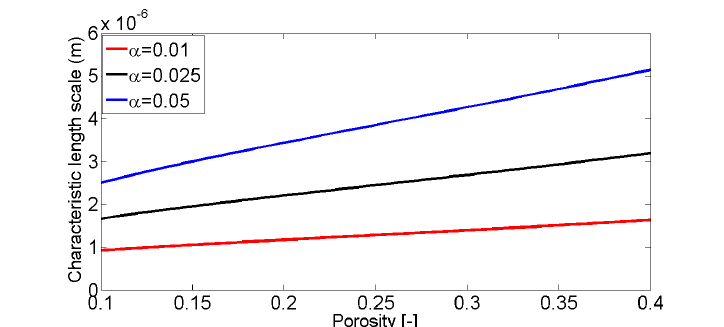
Figure 8. The variation of the characteristic length scale with porosity at three different values of α (0.01, 0.025 and 0.05) for d = 50 × 10 − 6 m.